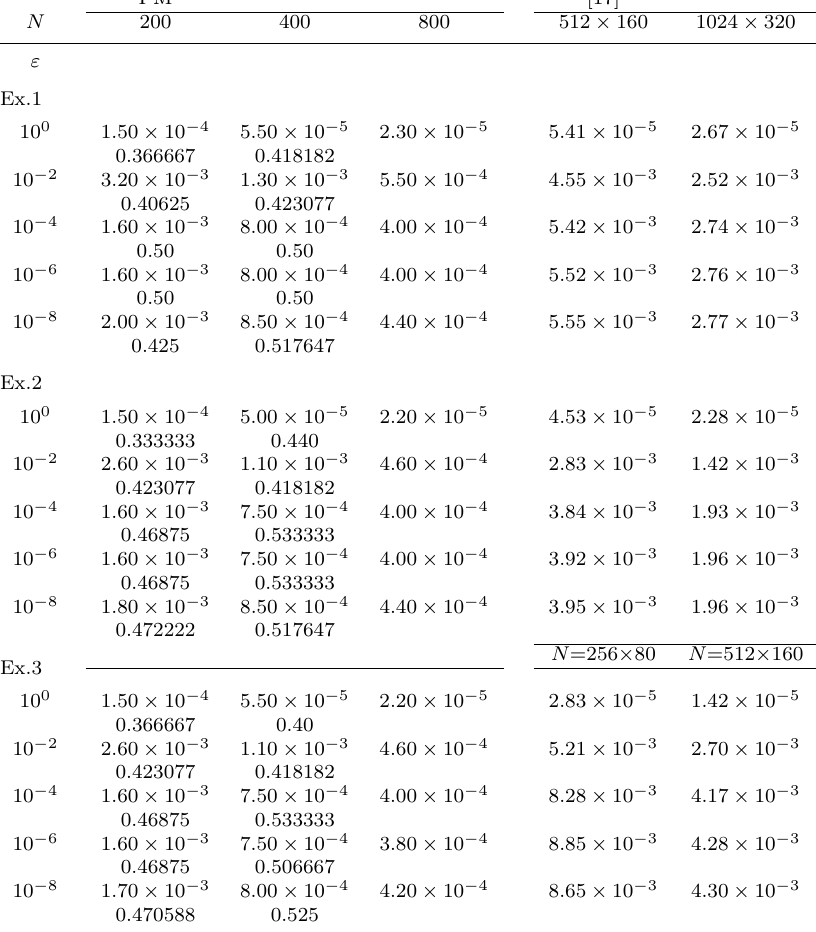
Table 2. Max absolute error ( E Y N,n ( x,t ) = Max |Y N,n ( x,t ) − y ( x,t ) | , ( x,t ) ∈ D ) with n = 10 and error ratio E Y 2 N,n / E Y N,n